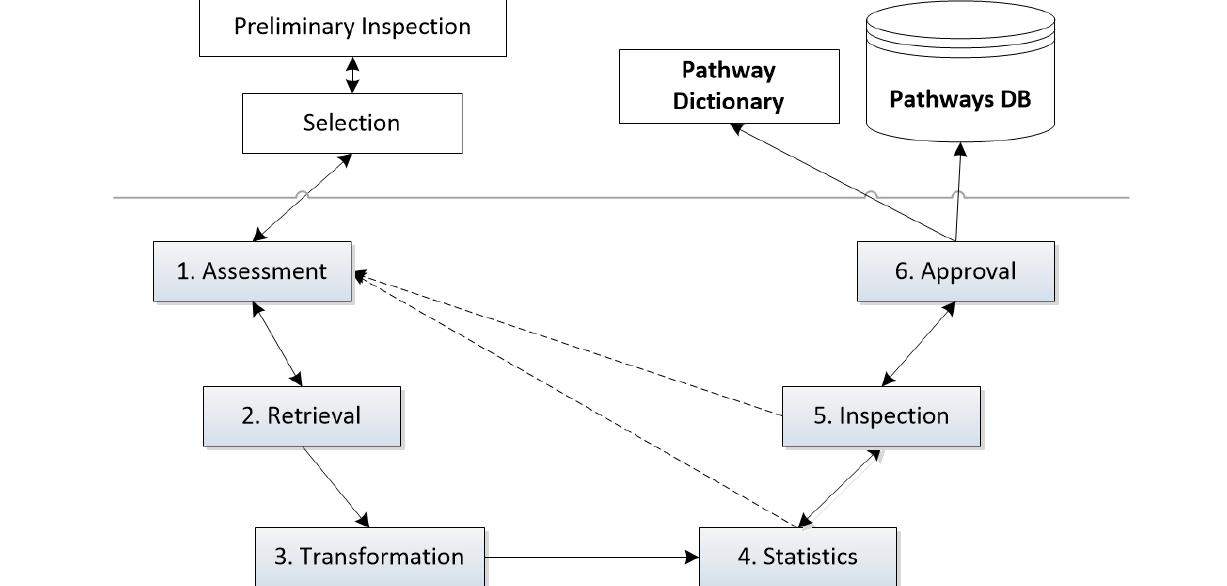
Figure 2. Methodology to build pathways’dictionary and database